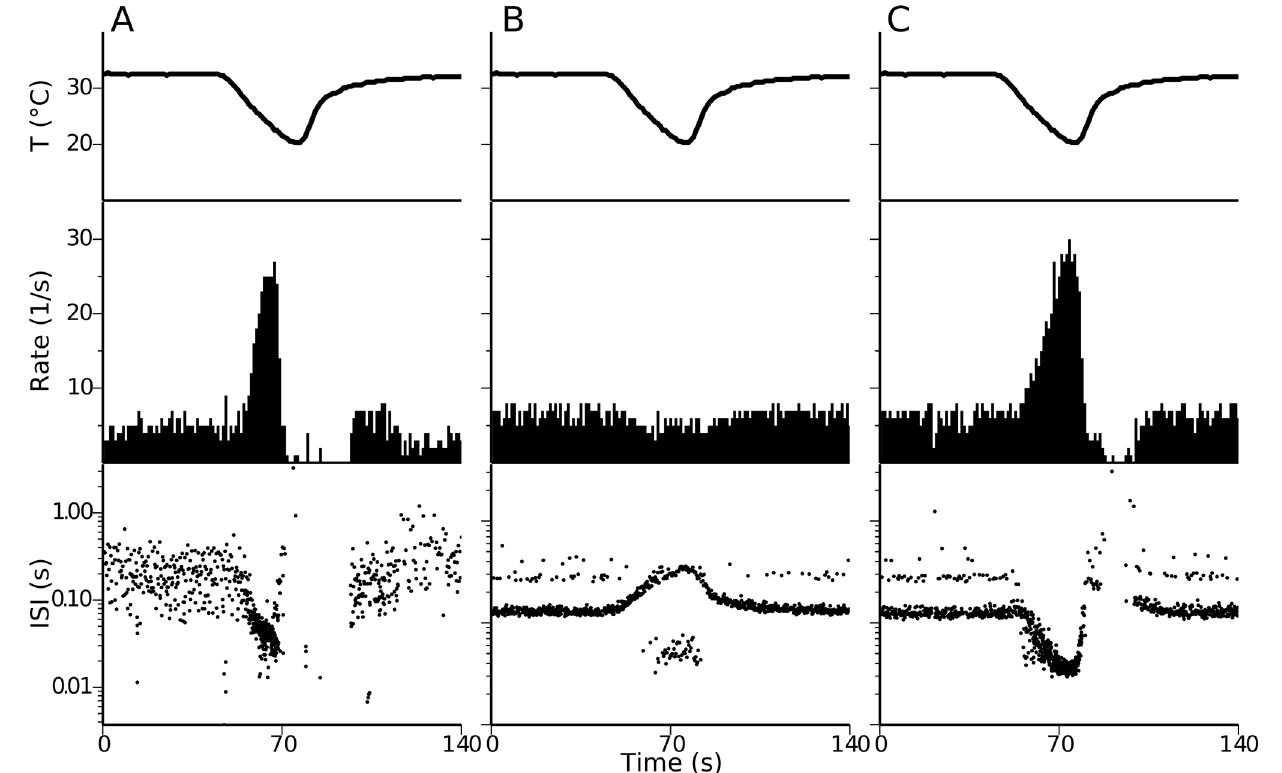
Fig 1. Dynamic response to cold in CS nerve endings and models. Experimental recording (A), simulation of the Huber & Braun model (B), and simulation of our model (C) exposed to the same temperature protocol (top). Middle panels show the firing rate (spikes/sec) and the bottom panels show the inter-spike intervals (log scale). Our model reproduces three main features of the experimental recording: The steady-state firing rate at the resting temperature of the skin; the increase in the firing rate in response to a temperature drop; and a silent period when the temperature is rising back. Parameter set is 92 (Table